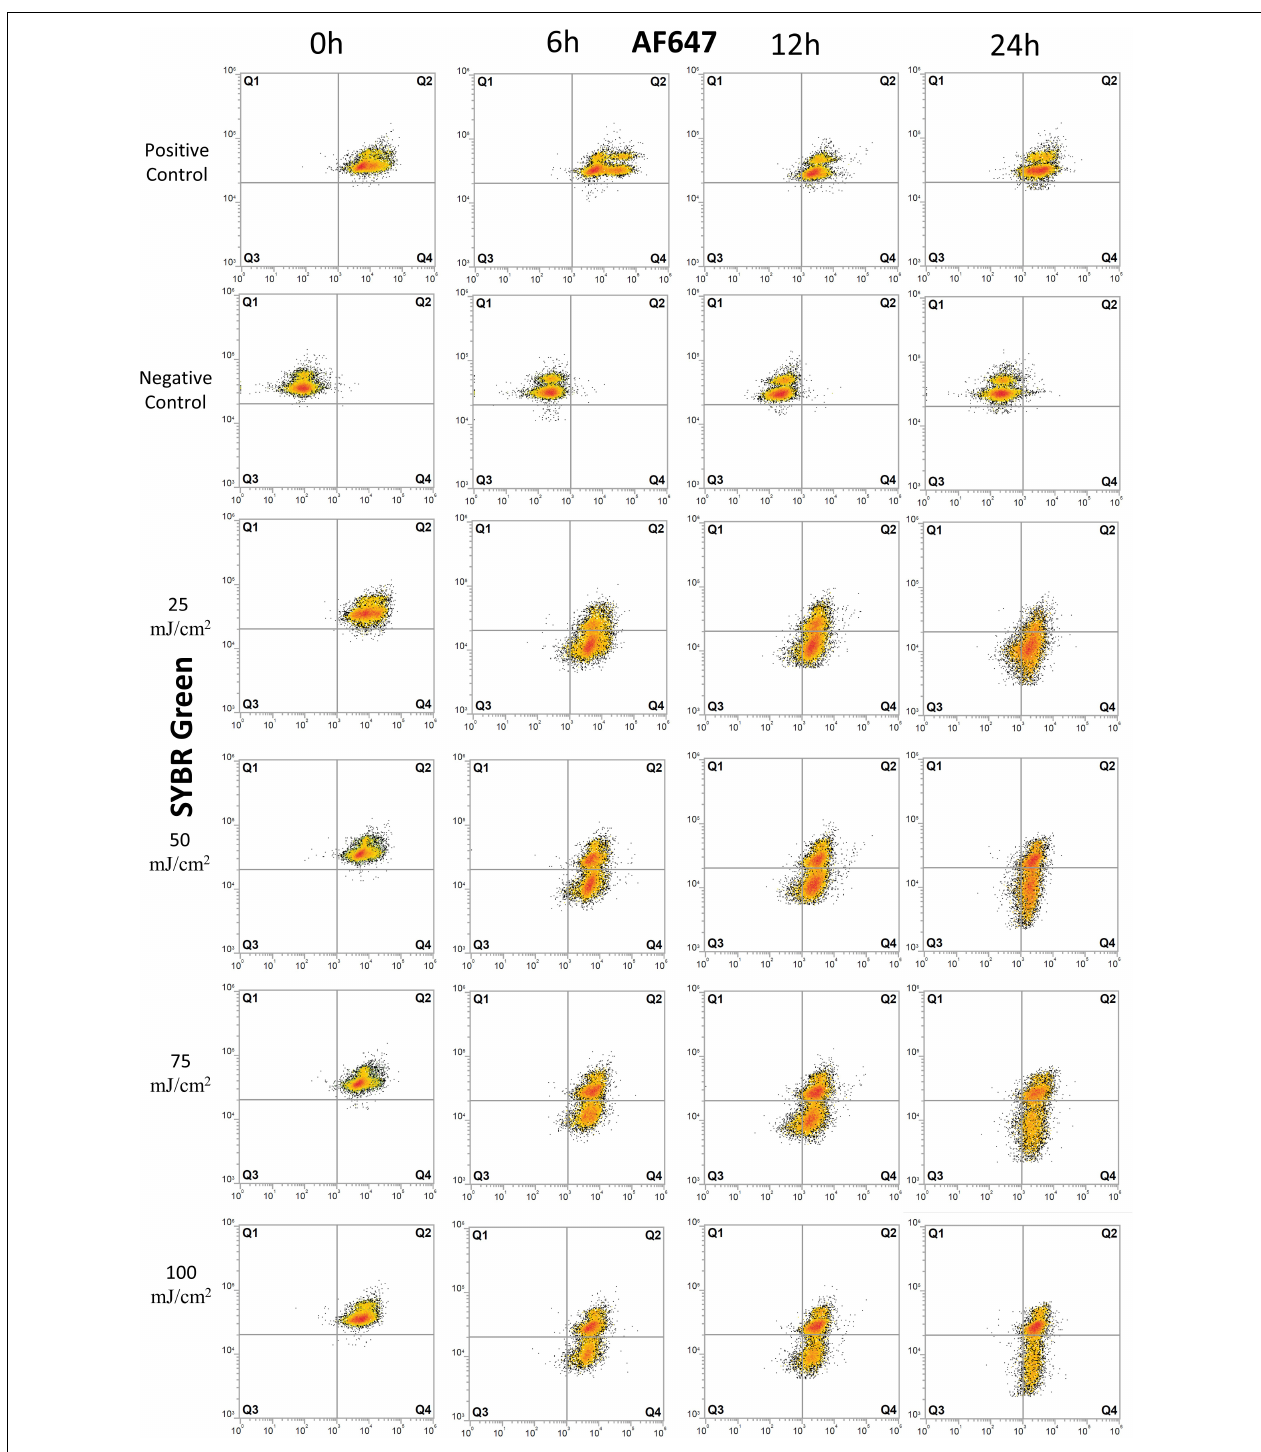
FIGURE 2 | Flow cytometry dot plots of E. coli cells treated with UV irradiation. Effects of UV doses of 25, 50, 75, and 100 mJ/m 2 on E. coli were monitored for degradation of DNA and for protein production at 0, 6, 12, and 24 h after treatment. Cells were stained with SYBR Green for DNA detection and AF647 for BONCAT. Between 5,000 and 10,000 cells were analyzed in each dot plot. Quadrant gates were designed from positive and negative HPG control with Q1: dead cells, the presence of intact DNA, negative BONCAT activity; Q2: live cells, the presence of intact DNA, positive BONCAT activity; Q3: dead cells, damaged DNA, negative BONCAT activity; and Q4: damaged cells with damaged DNA and positive BONCAT activity. The results of UV dose of 200 mJ/m 2 are not included as they present similar pattern as lower UV doses.